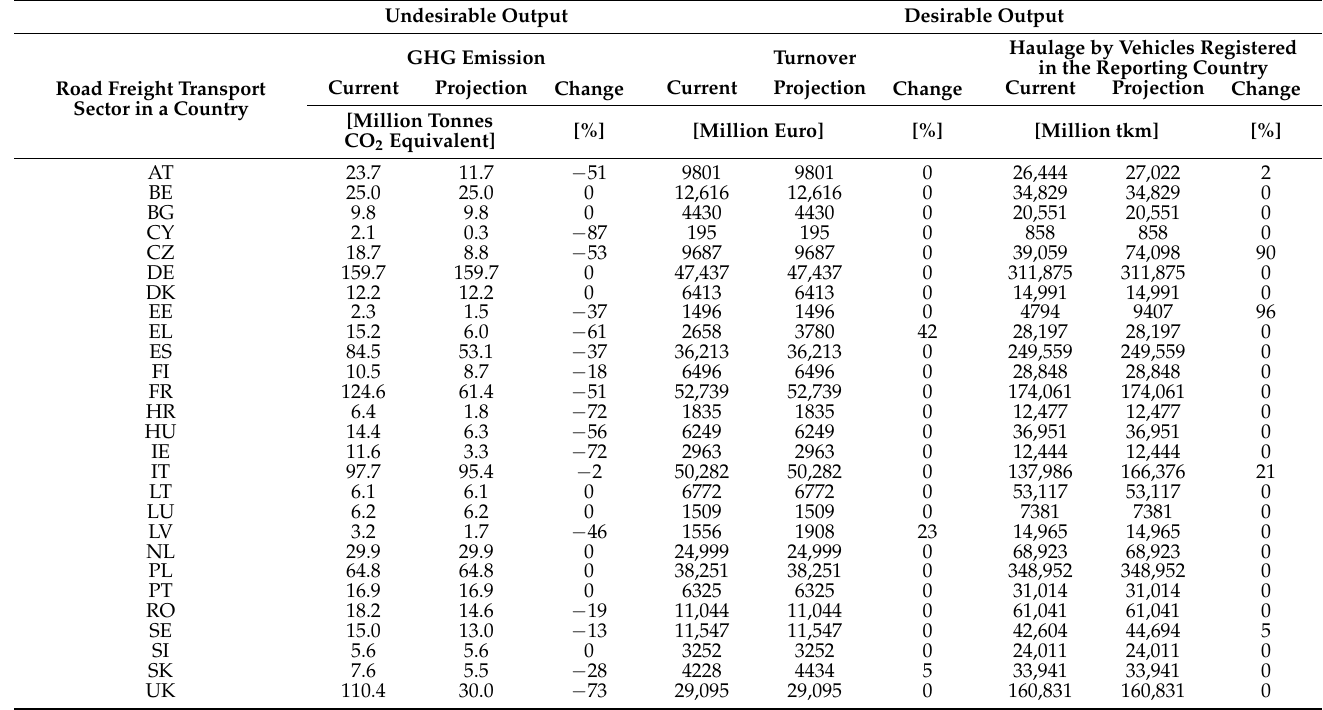
Table 6. Recommendations for increasing or decreasing the output for the road freight transport sectors by EU countries to improve